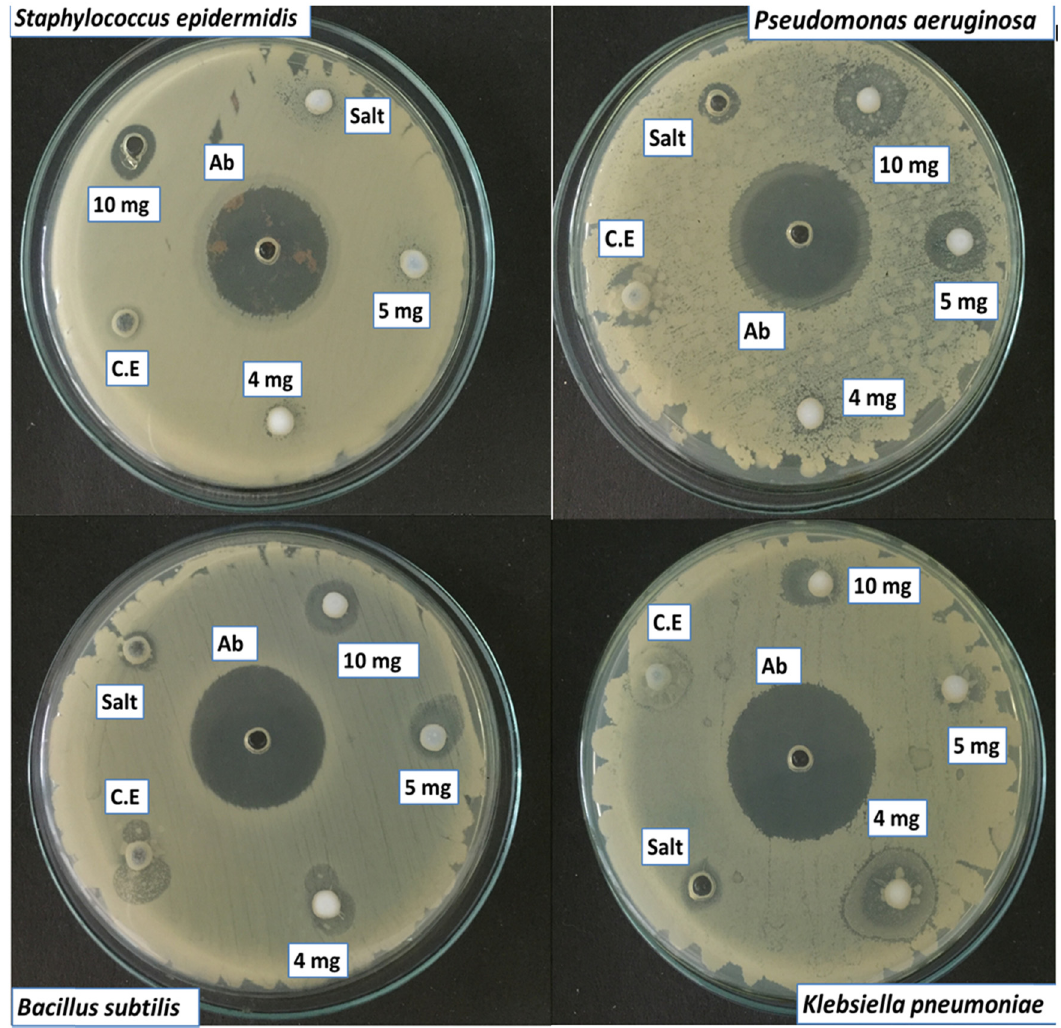
Figure 9: Antibacterial activity of ZnO - NPs at di ff erent concentrations ( 10, 5, and 4 mg · mL − 1 ) ; Ab – antibiotics, CE – callus